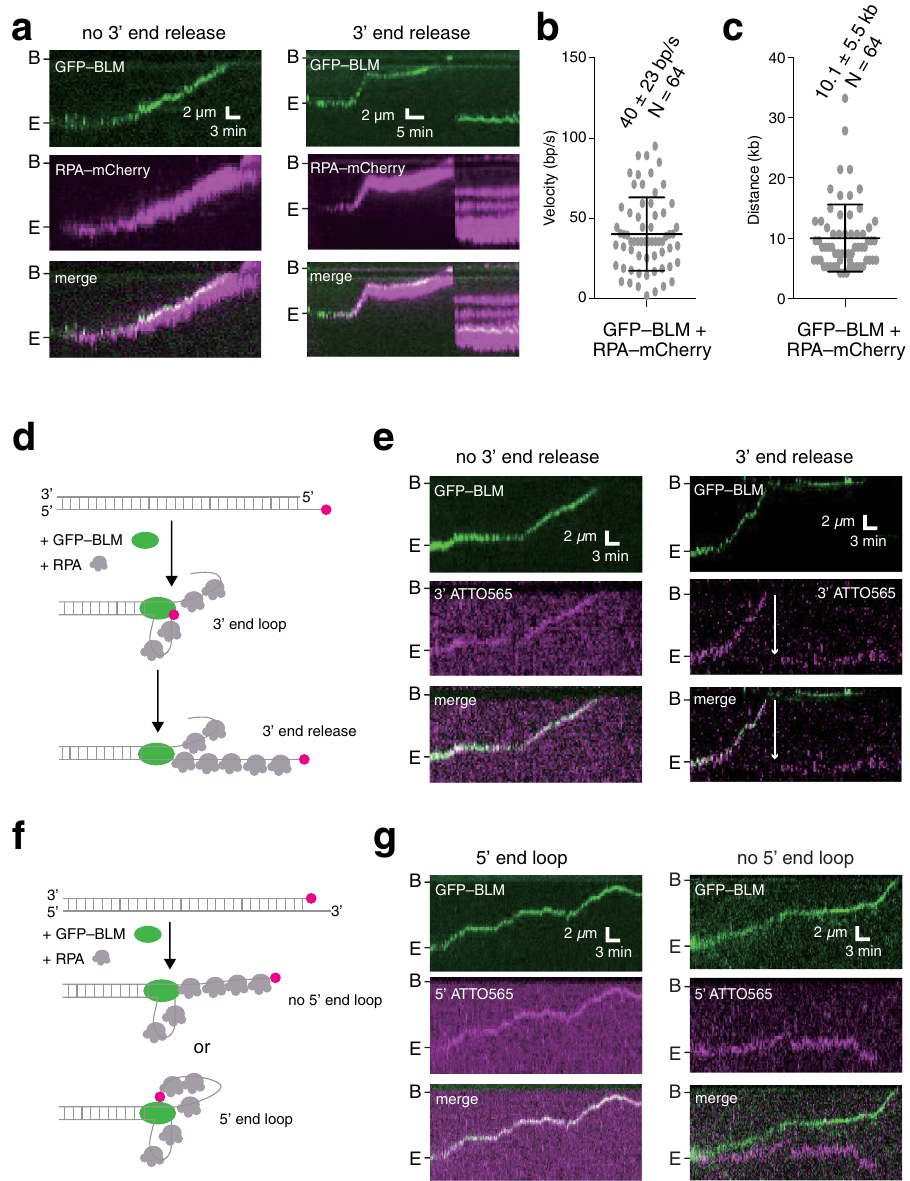
Fig. 3 DNA2 is not necessary for ssDNA looping. a Kymographs showing examples with and without evidence for 3 ′ ssDNA loop release in reactions with 0.2 nM GFP-BLM (green) and 2 nM RPA-mCherry (magenta). b Velocity distribution for GFP-BLM in reactions with RPA-mCherry. The center bar represents the mean of the data and error bars represent SD. Also see Supplementary Table 1. c Processivity of GFP-BLM in reactions with RPA-mCherry. The center bar represents the mean of the data and error bars represent SD. Also see Supplementary Table 1. d Schematic of reaction with GFP-BLM and RPA with a 3 ′ ATTO565-labeled DNA substrate. e Kymographs showing examples where the 3 ′ ATTO565-labeled ssDNA end (magenta) is either released or not released in reactions with GFP-BLM (green) and unlabeled RPA. Note, 3 ′ end release is highlighted with a white arrowhead. f Schematic of reaction with GFP-BLM and RPA with a 5 ′ ATTO565-labeled DNA. g Kymographs showing examples where the 5 ′ ATTO565-labeled ssDNA end (magenta) either does or does not track with the GFP-BLM (green) in reactions with unlabeled RPA.